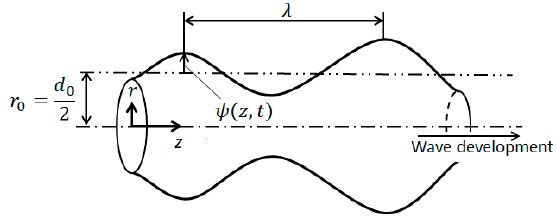
Figure 3. Surface wave on a cylindrical liquid column.